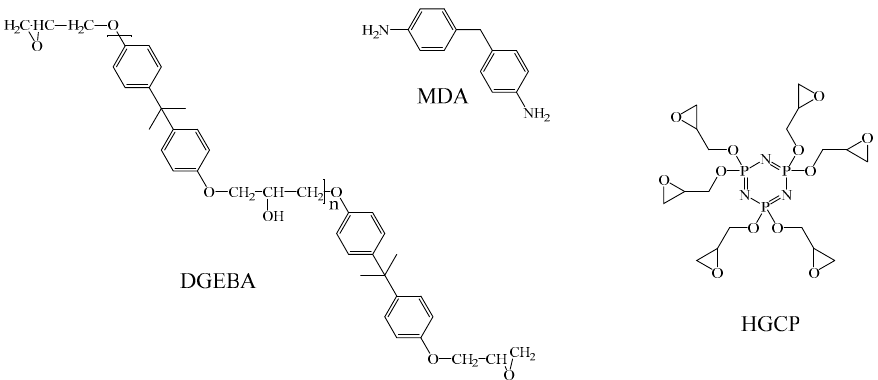
Figure 1. Chemical structures of the epoxy materials and the curing agent.